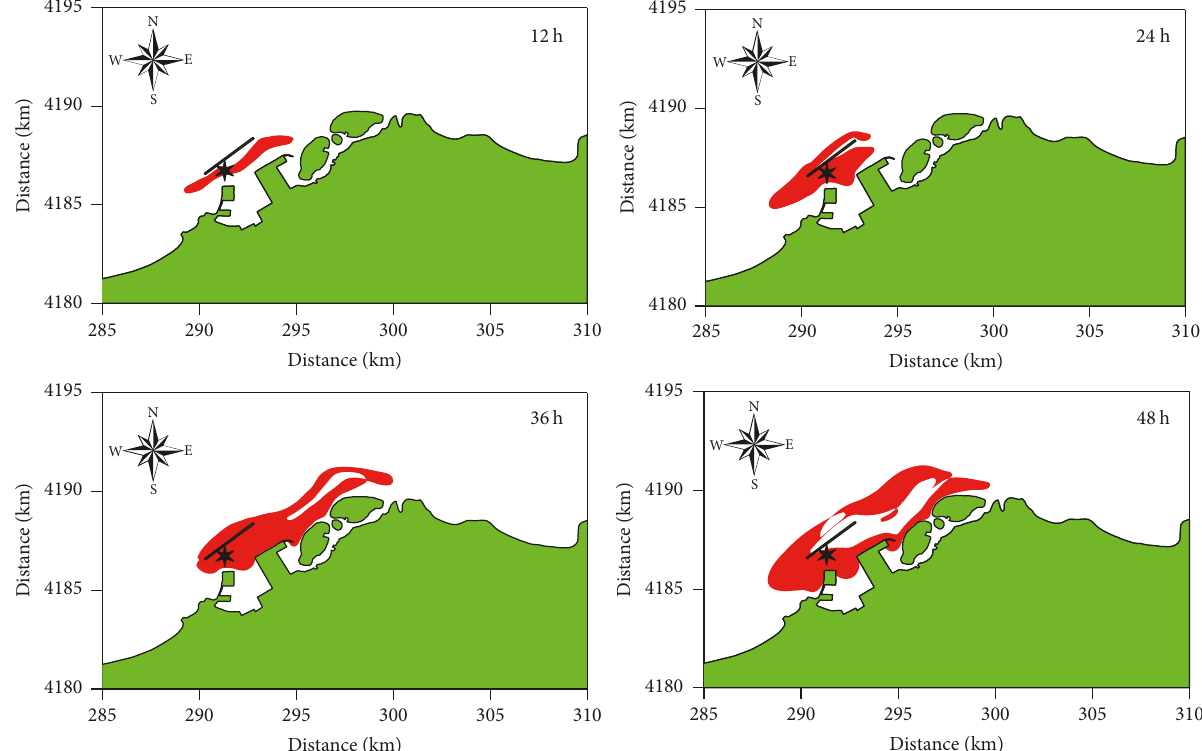
Figure 18: Transport processes of continuous oil spills (red area) from the western portion of the channel (black star symbol for the western spill location) in the case of no